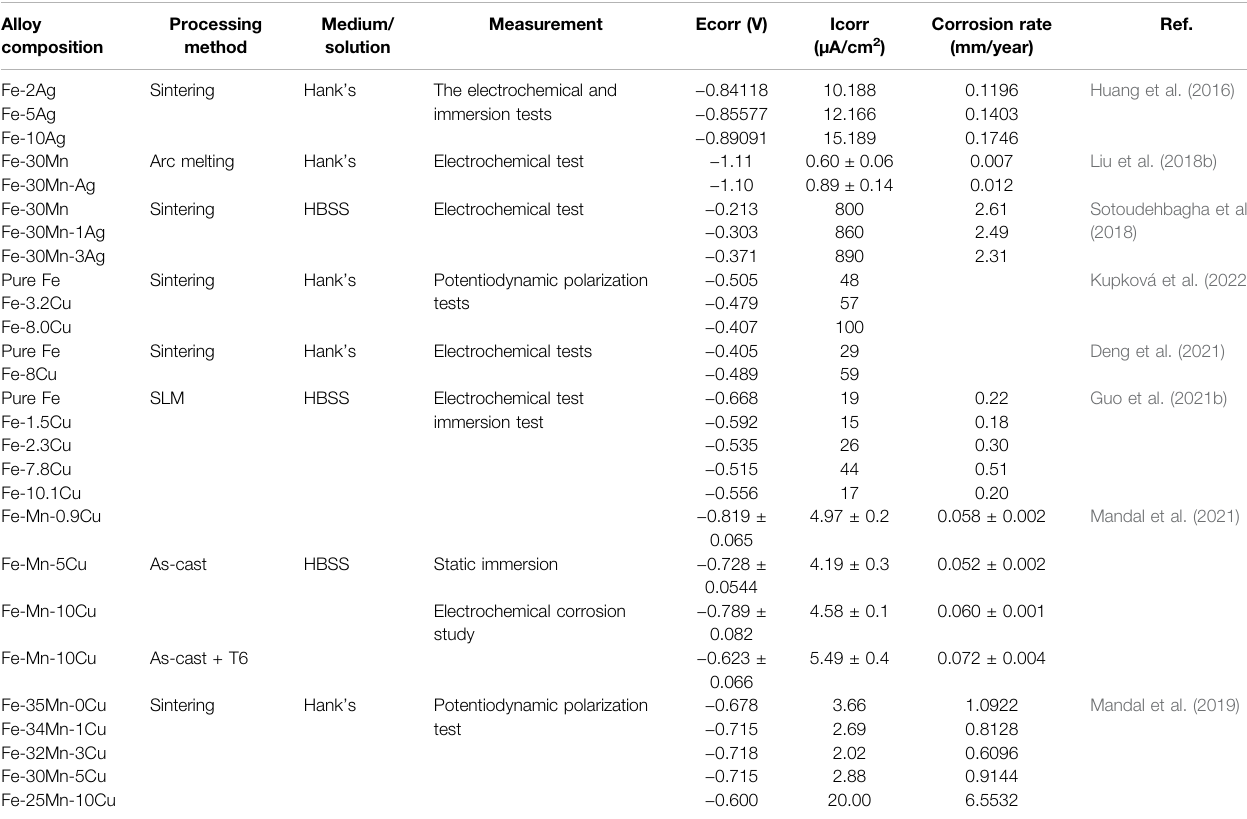
TABLE 8 | Corrosive properties of Fe-based alloys with antibacterial properties as orthopedic implants. Alloy